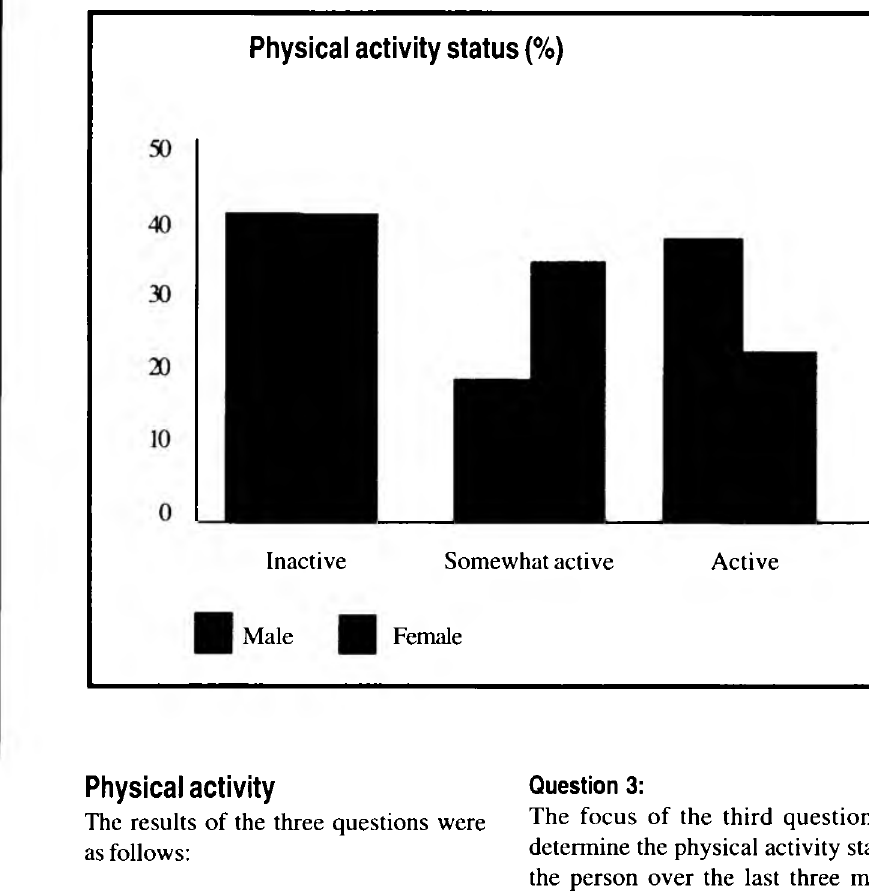
FIGURE 5: Participant’s physical activity status (n=218) Physical activity status